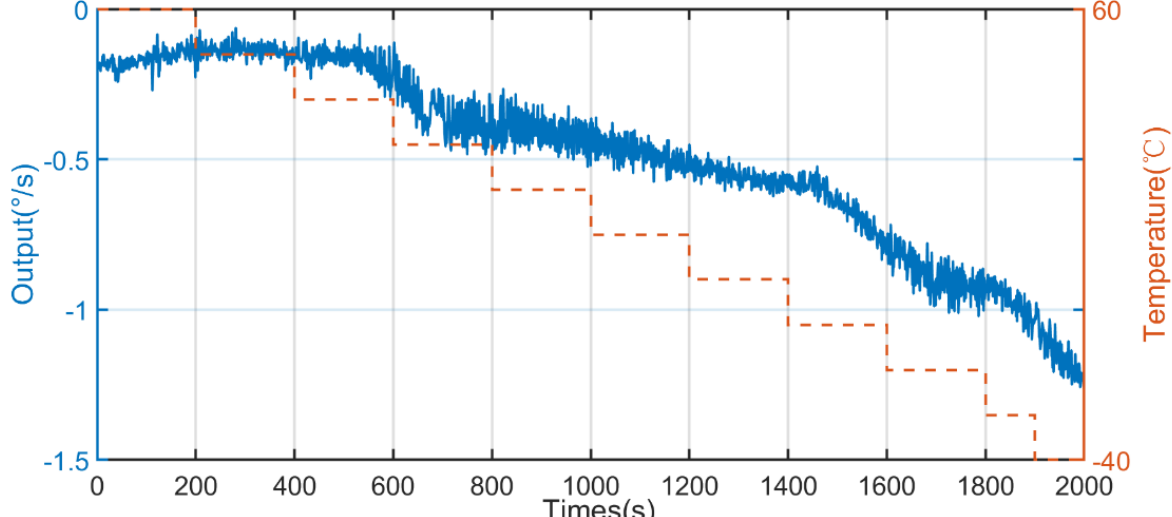
Figure 13. The output of the gyroscope based on the X axis from − 40 to 60 °C.